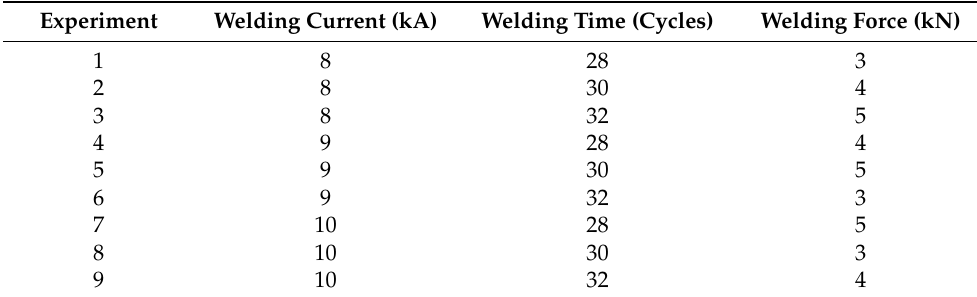
Table 2. Experimental design using the Taguchi